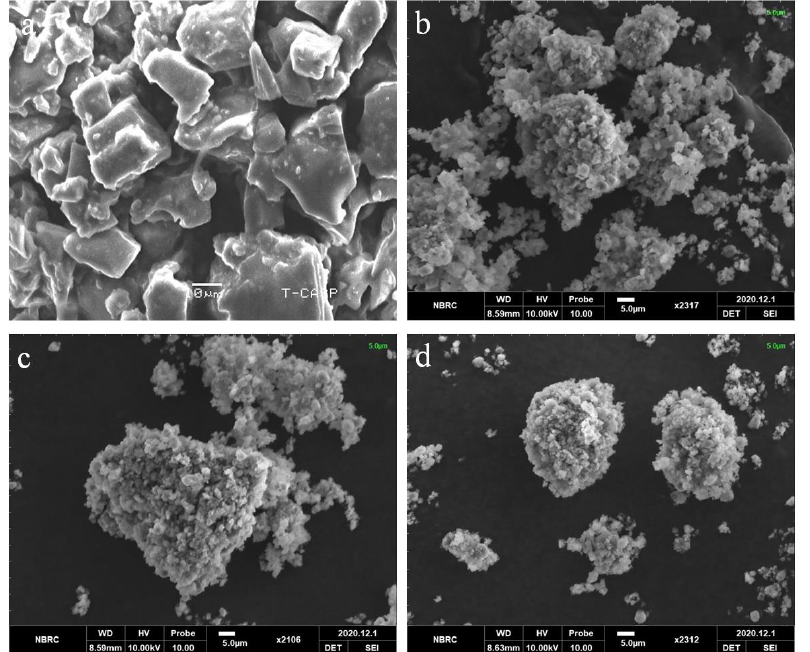
Figure 4. SEM images of ( a ) Dex, ( b ) S1, ( c ) S18, and ( d ) S23.